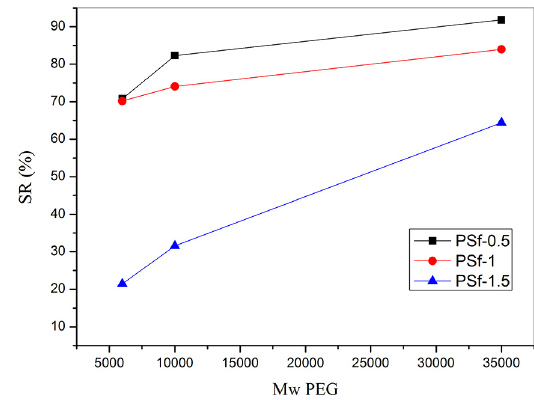
Figure 11: Effect of MC dosage on solute rejection of the